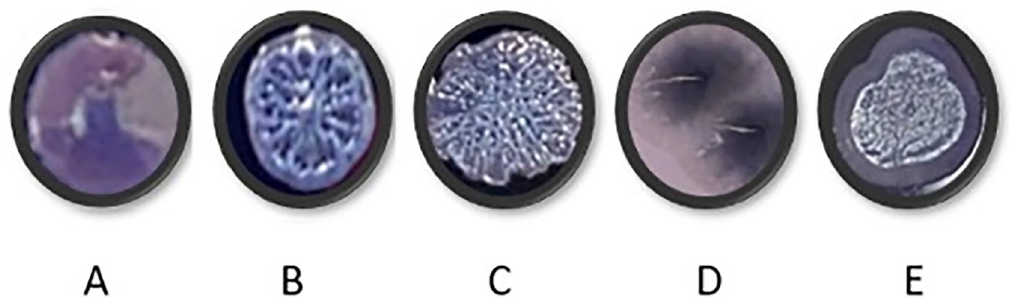
Figure 7. Representative colony morphologies observed during PAO1 culture over forty days (Table 14). Cultures were streaked onto TCCA plates that contained Congo red and Coomassie blue to check for changes in colony morphologies. The plates were incubated at 37 ° C overnight and at room temperature for 48 hours before analysis. (B and C: wrinkly morphotypes, A: starting culture, D and E: colonies only observed in CF media.